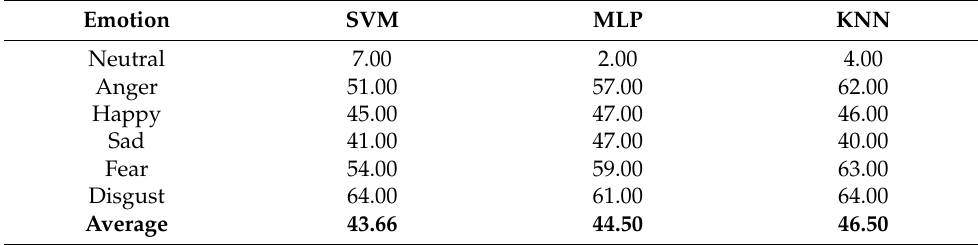
Table 9. Percentage EER using SVM, MLP, and KNN classifiers using the RAVDESS